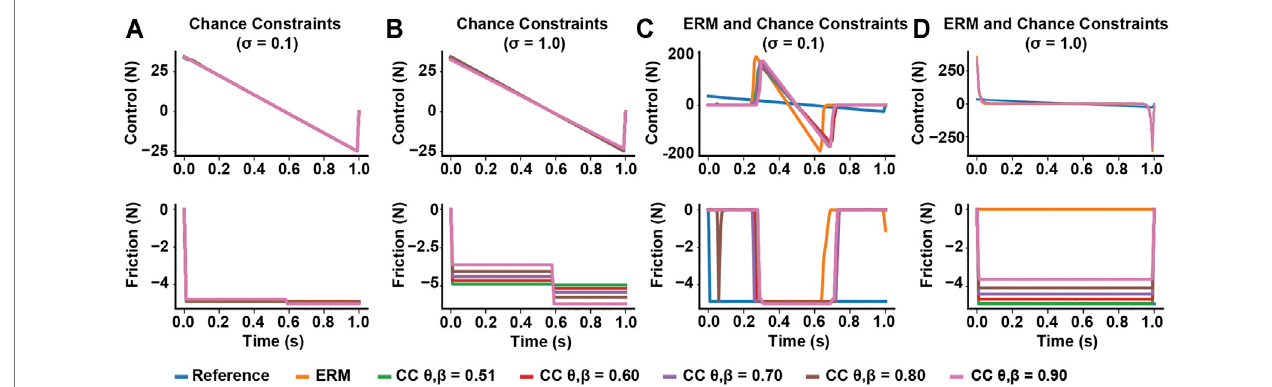
FIGURE 2 | Effects of including chance constraints on contact-robust optimization at different uncertainty levels, for different risk bounds. (A,B) Including chance constraints without a robust cost, such as the ERM, does not have much effect on the optimized open-loop control, but can allow the friction force to vary under high uncertainty. (C,D) Includingchanceconstraintswithacontactrobustcosthaslittleeffectontherobustsolutionatlowuncertainty,buttighteningtheriskbounds θ and β increases the friction force magnitude at high